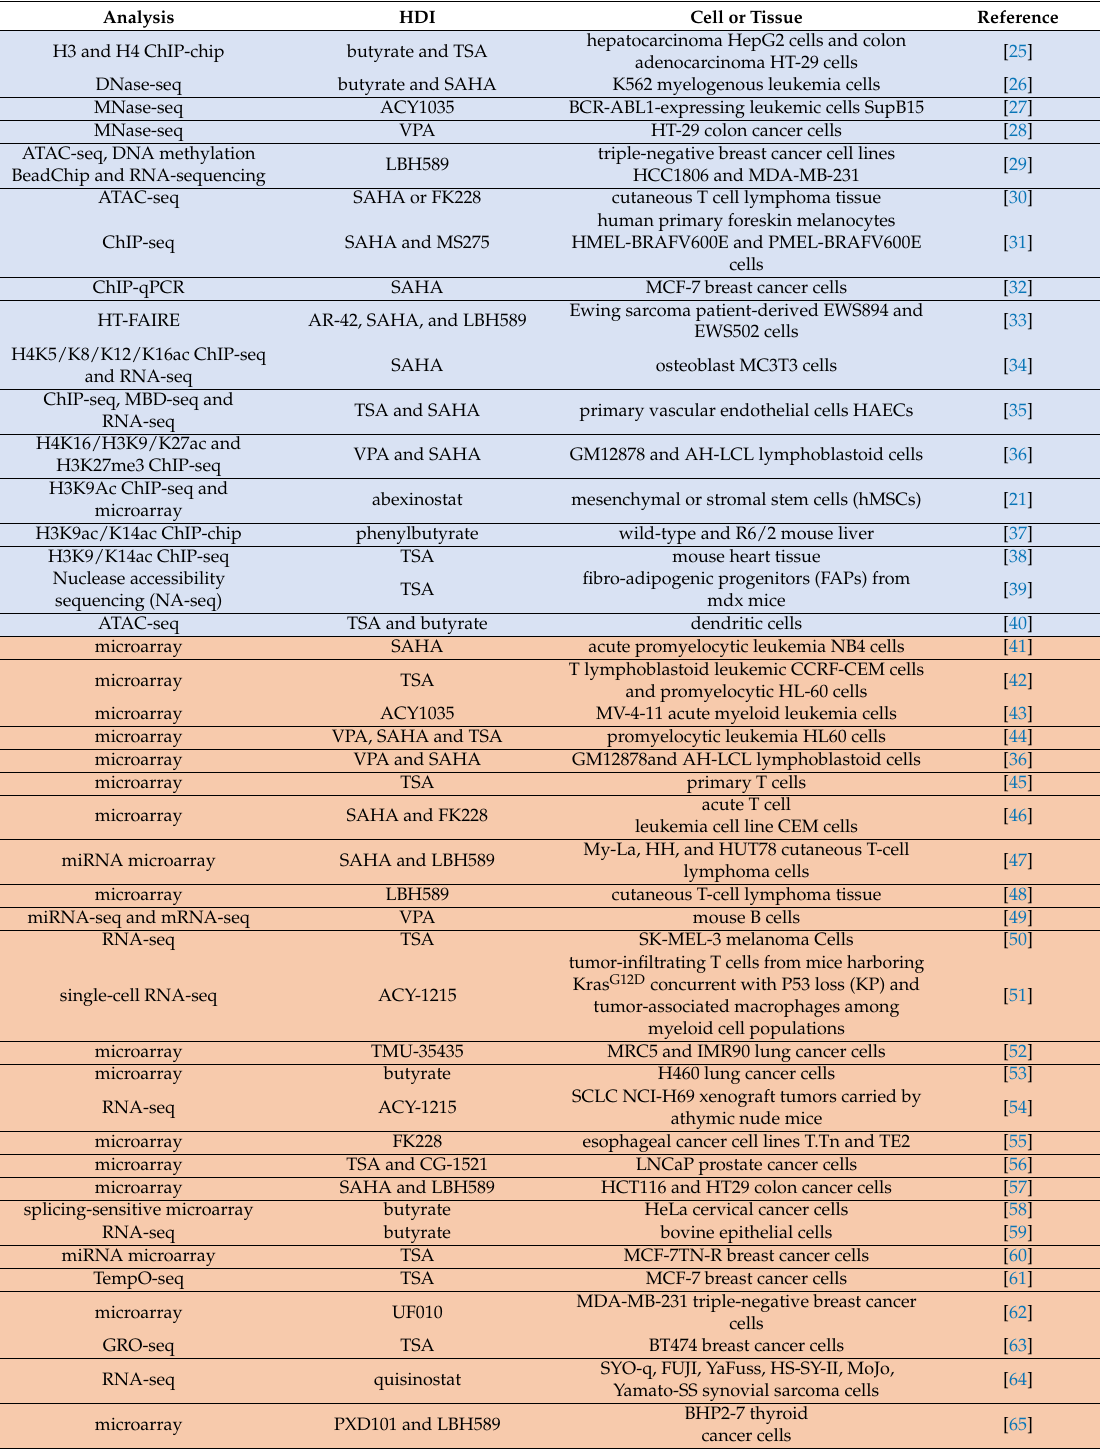
Table 1. Epigenomics (blue), transcriptomics (orange), proteomics (gray), metabolics (green), and chemoproteomics (yellow) studies of histone deacetylase inhibitors (HDIs). Cells are from human origin unless otherwise